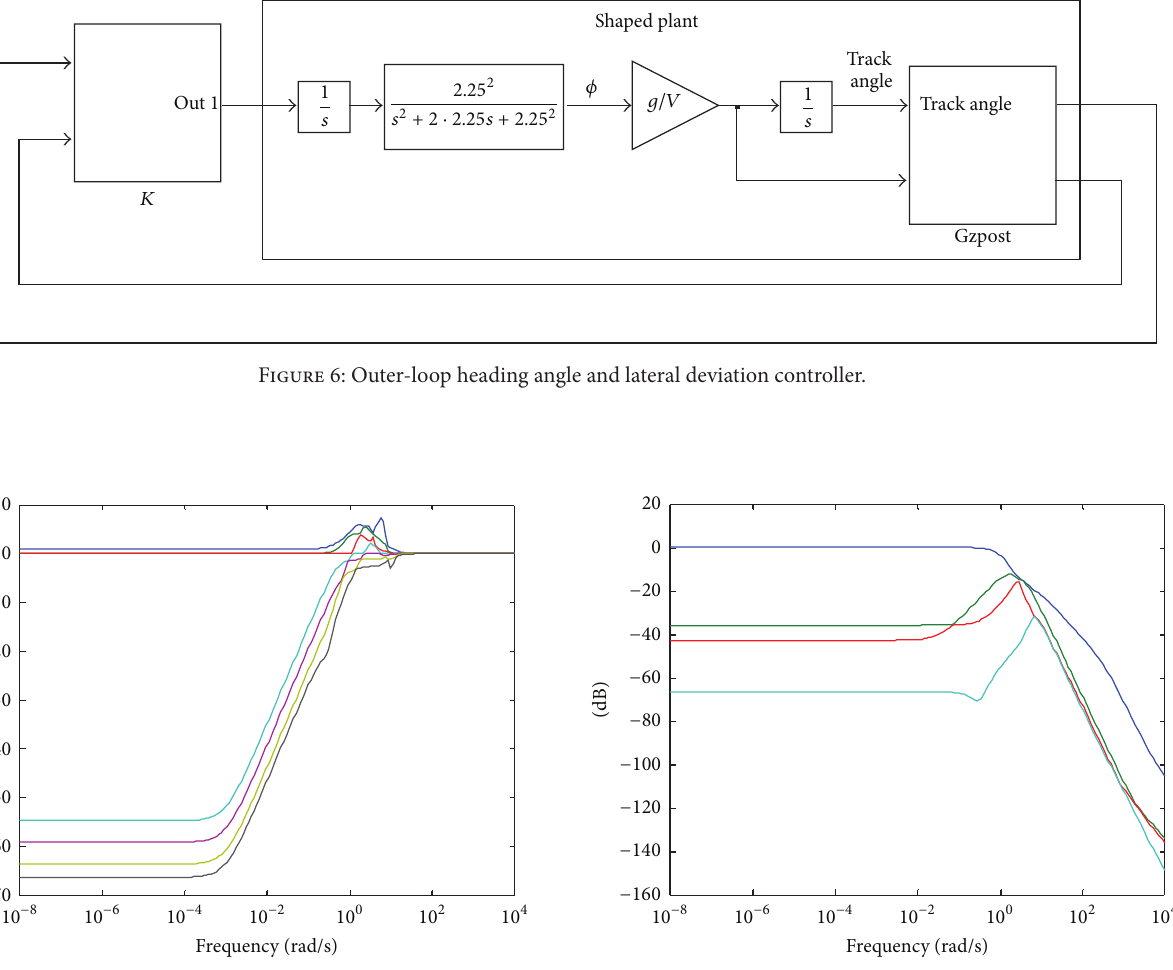
Figure 7: Singular values of the sensitivity function. Figure 8: Singular values of the control